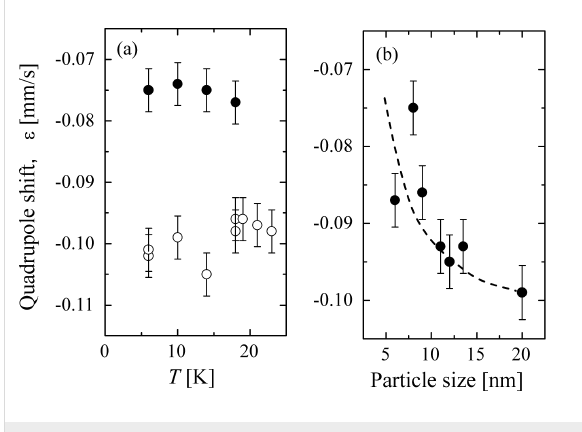
Figure 8: (a) The quadrupole shift of coated (open circles) and uncoated (solid circles) 8 nm hematite particles as a function of temperature. (b) The quadrupole shift of uncoated hematite nanoparticles at 20 K as a function of particle size. Reprinted from Frandsen, C.; Mørup, S. Spin rotation in α -Fe 2 O 3 nanoparticles by interparticle interactions, Phys. Rev. Lett . 2005, 94, 027202. Copyright (2005) by the American Physical